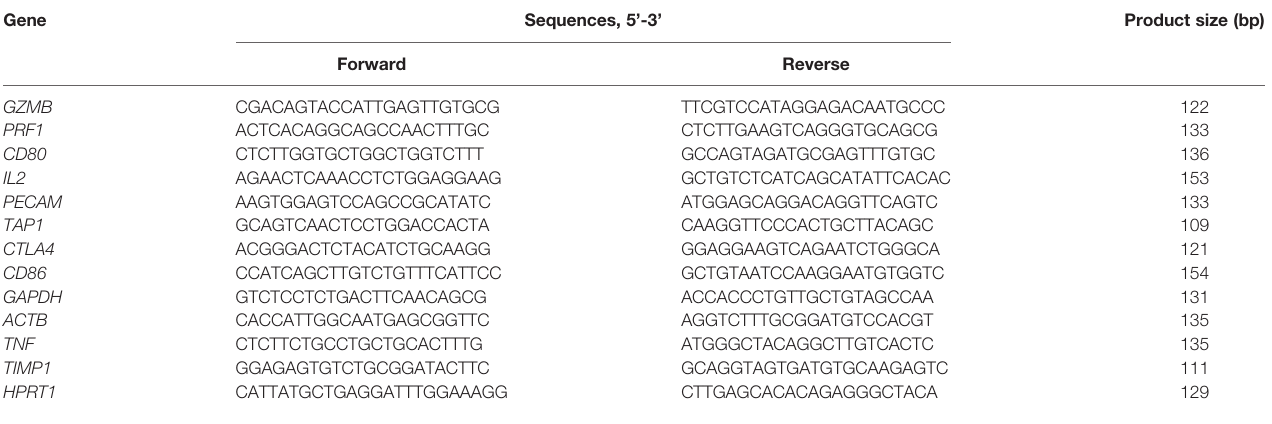
TABLE 1 | Primer sequences used for Real-Time qPCR and the expected product size.